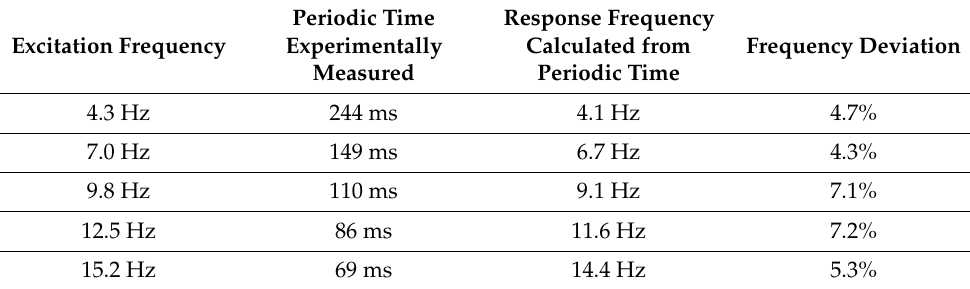
Table 1. Excitation and response frequencies and the deviation for Side C. Periodic Time Excitation Frequency